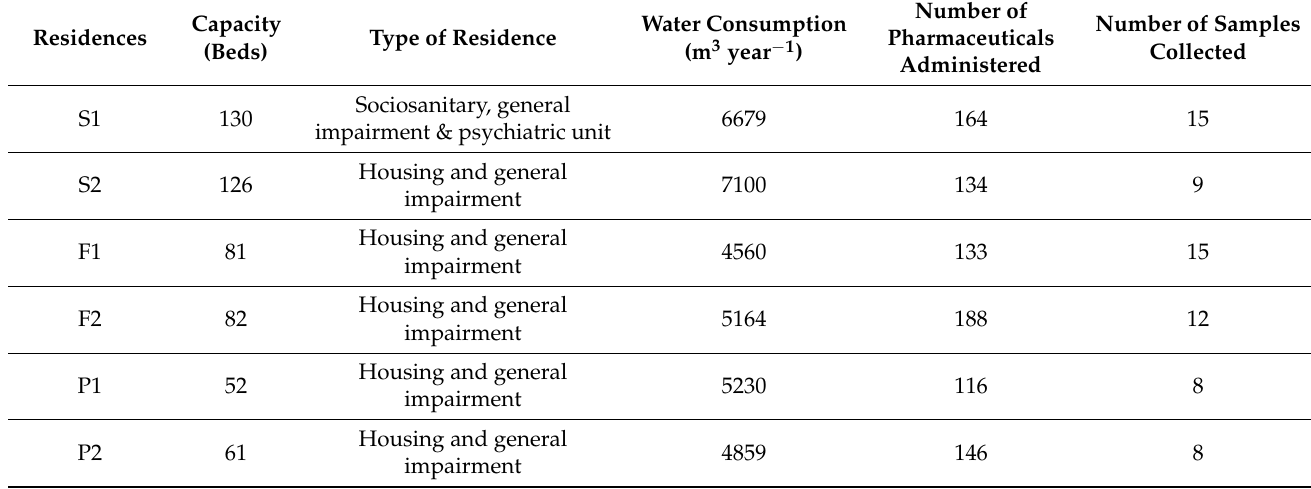
Table 1. Characteristics of the residences sampled, indicating their origin, the capacity as number of beds, the type of residence, the water consumption, the number of pharmaceuticals administered during the period of sampling and the main compounds